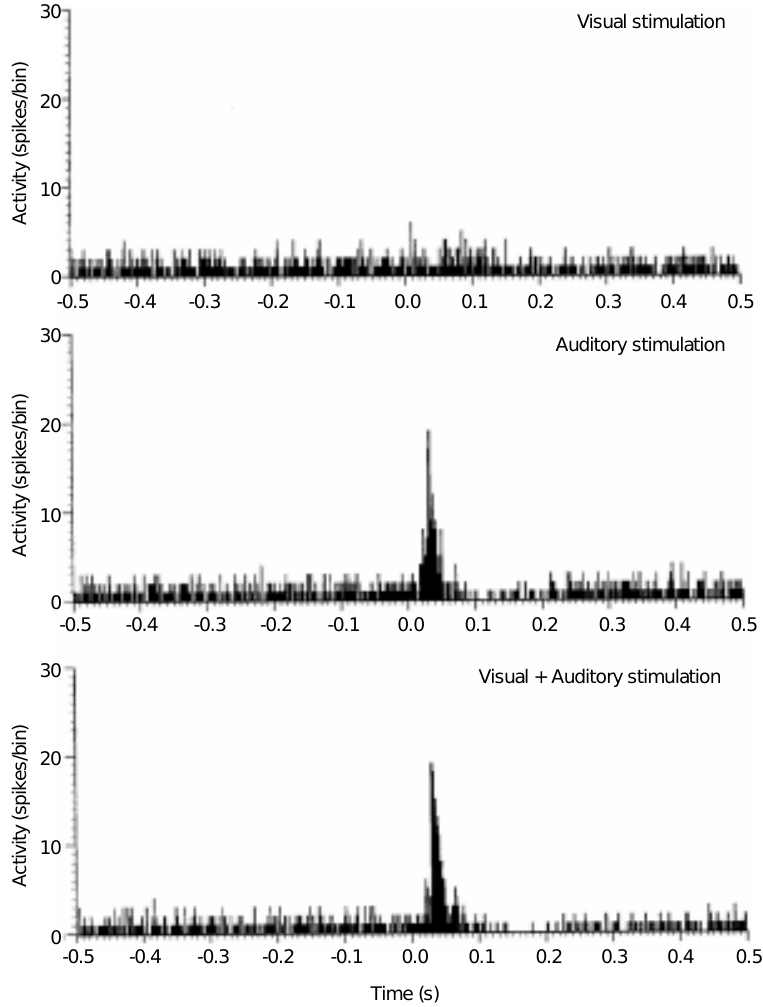
Figure 1. Peri-stimulus time histograms of a non-serotonergic neuron that did not respond to visual (upper panel) stimulation, but responded to auditory stimulation (middle panel) and to visual + auditory stimulation (bottom panel). One hundred stimuli were presented in each case. This neuron was located in the nucleus raphe pallidus. Bin width is 1